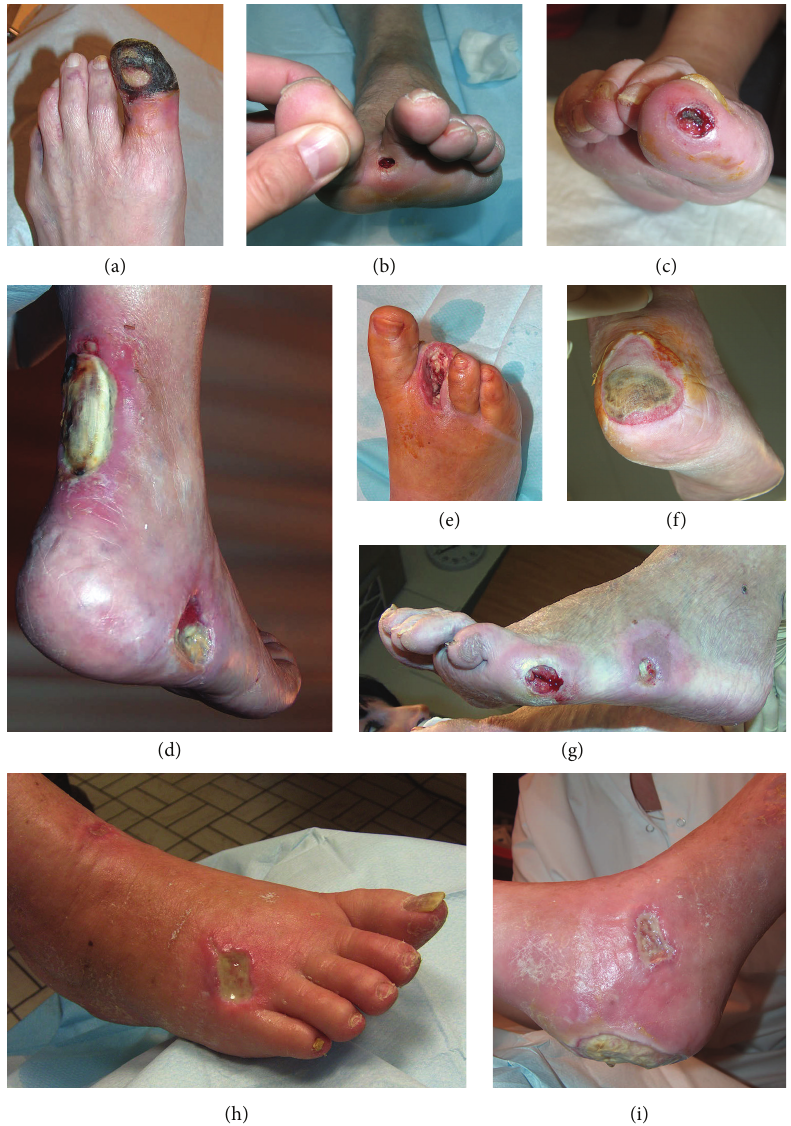
Figure 3: Examples of wounds with ambiguous angiosome categorization. (a), (b), (c), (e) Circumferential necrosis, wounds located at the tip or interdigital webspace, and nonhealing amputation sites do not allow differentiation between angiosomes derived from the anterior and posterior tibial artery. (d) Territories such as the achilles tendon are not equivocally associated with a particular angiosome. (f), (g) Wounds that extend into an adjacent angiosome, or lie on the verge of two angiosomes. (h), (i) Two pictures of the same foot showing multiple wounds (dorsal, medial malleolar, and heel) residing in different